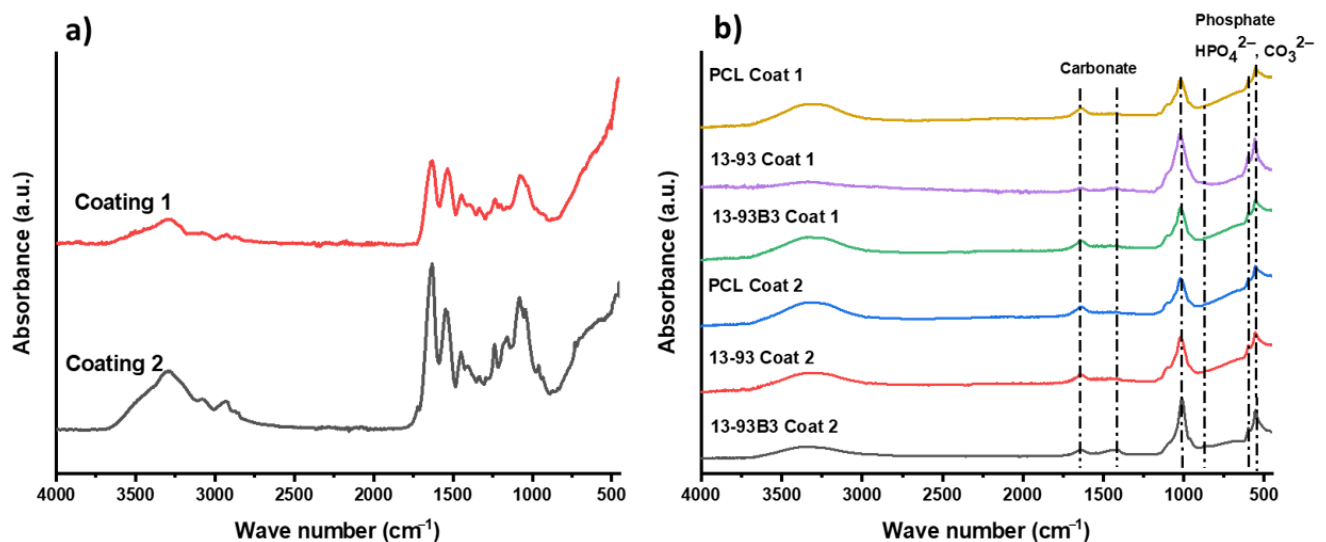
Figure 5. FTIR spectra of coated scaffolds before ( a ) and after ( b ) 7 days of immersion in SBF. The relevant bands are described in the text.